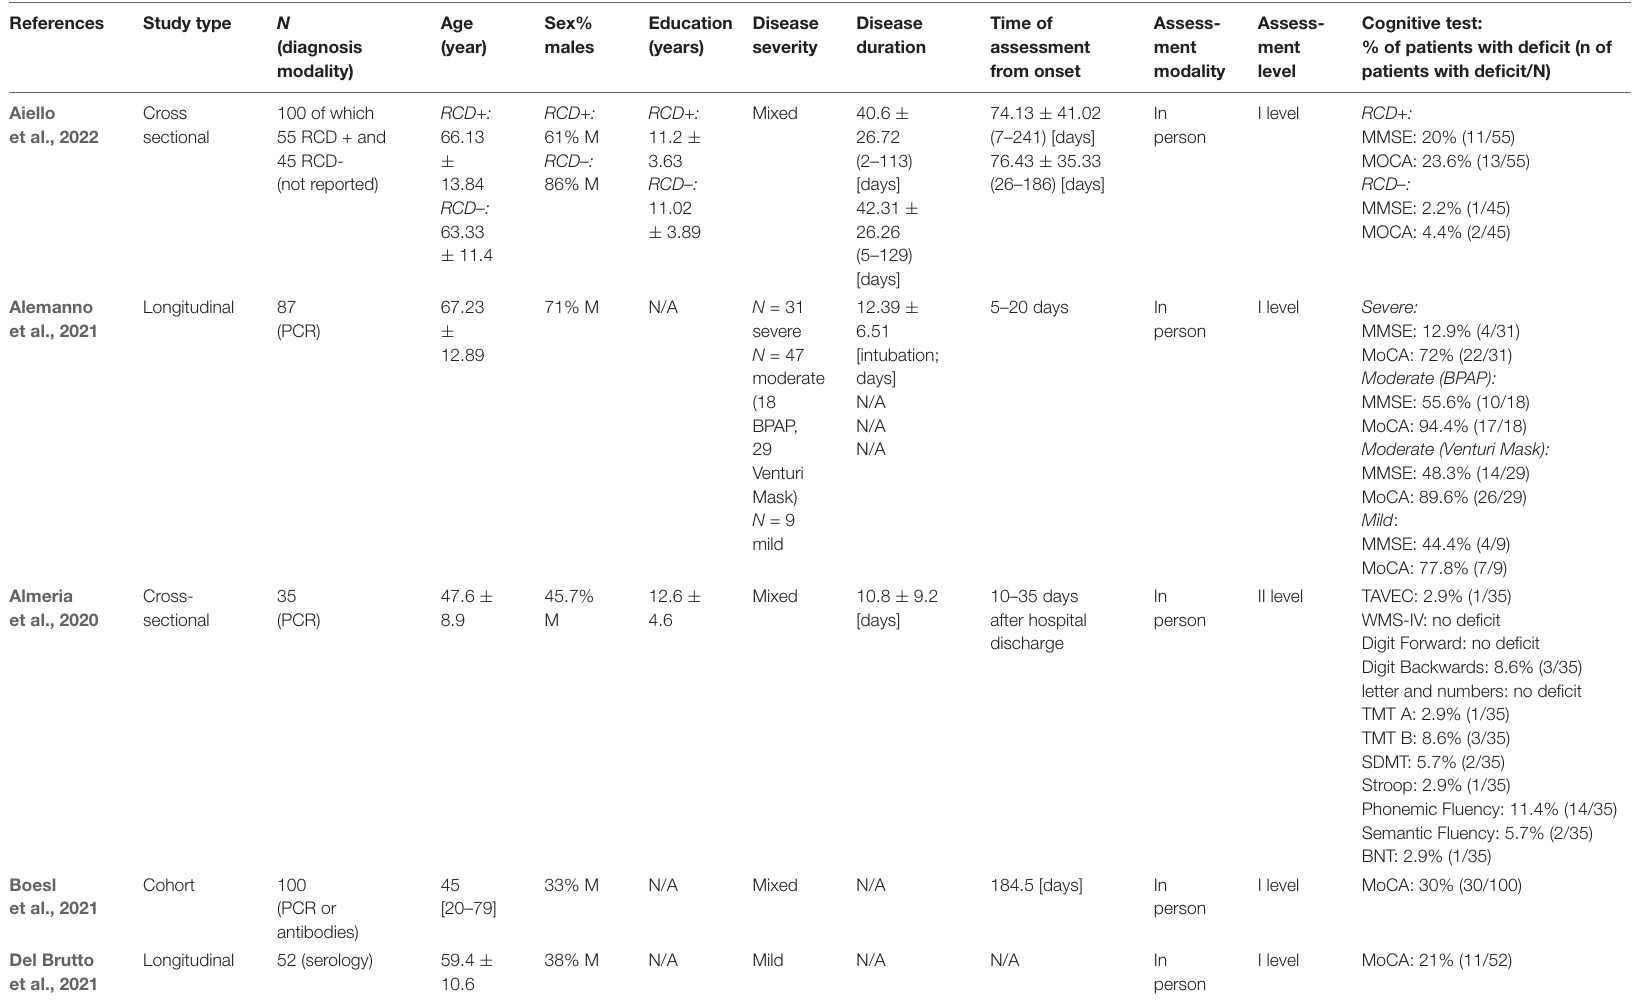
TABLE 1 | List of included